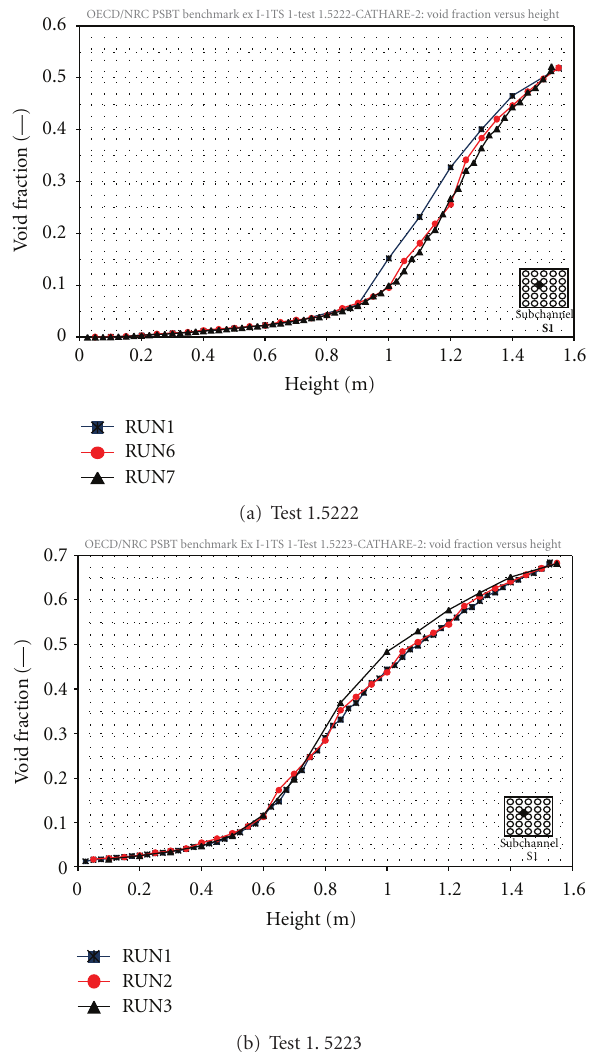
Figure 6: PSBT steady-state bundle (TS 6)—CATHARE2 3D and 1D models: central and bundle void fraction exp. versus calc., reference